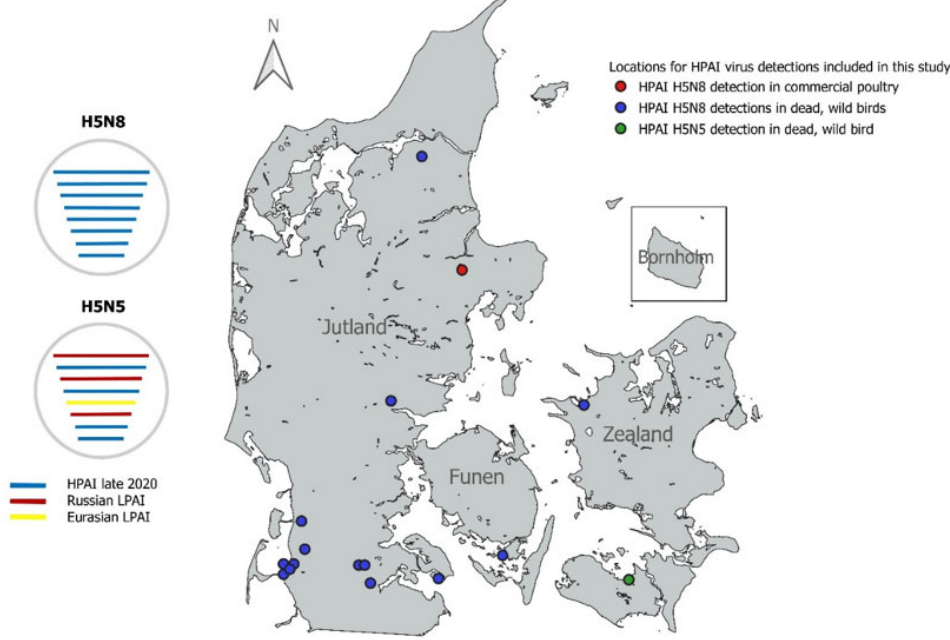
Figure 1. Schematic representation of the HPAI H5N8 and H5N5 viruses and geographic distribution of the viruses included in this study. The schematic representation shows the likely origin of the individual gene segments of the Danish H5N8 and H5N5 viruses. Blue bars represent gene segments that were most closely related to European HPAI H5N8 viruses from late 2020. Red bars represent segments that were closely related to Russian LPAI viruses from wild birds. Yellow bars represent gene segments that were closely related to LPAI viruses from wild birds elsewhere in Eurasia. On the map, every dot represents one bird found infected with HPAI virus. The blue dots represent dead, wild birds infected with HPAI H5N8 viruses. The red dot denotes the HPAI H5N8 detection from a commercial poultry. The green dot represents the H5N5 detection in a dead, wild peregrine falcon. The map was constructed with QGIS version 13.18.2 [20] using an outline of Denmark from Kortforsyningen (www.kortforsyningen.dk, downloaded 26/04/2012).